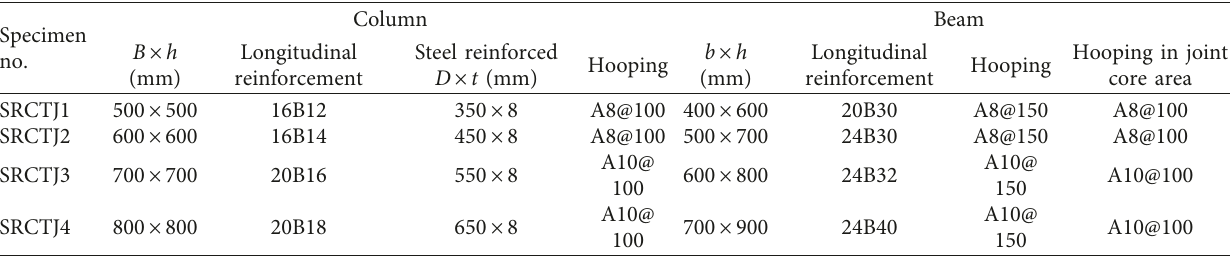
Table 5: Size, reinforcement, and structure of